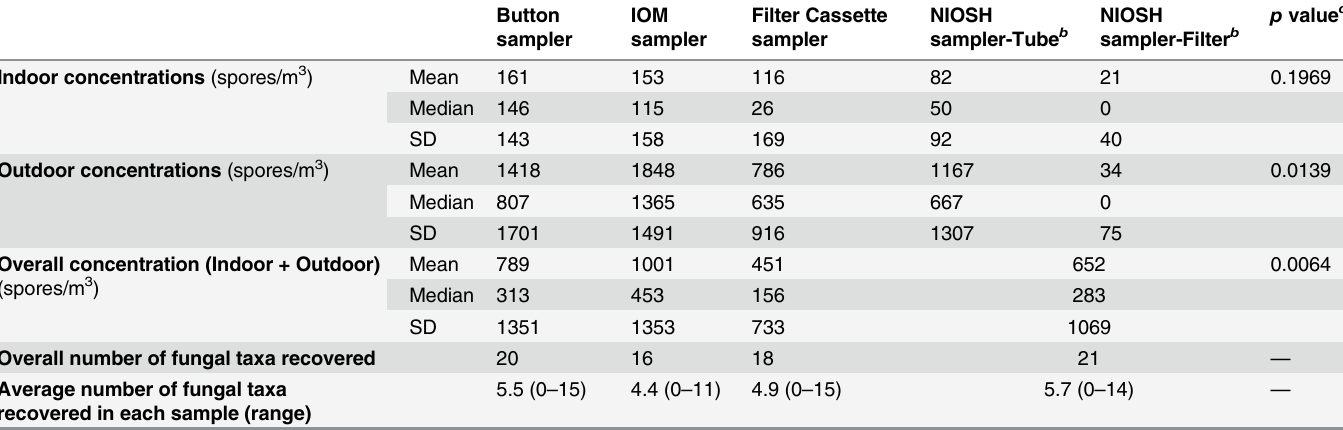
Table 6. Relative efficiency comparison of personal samplers based on total fungal spore concentrations and diversity.